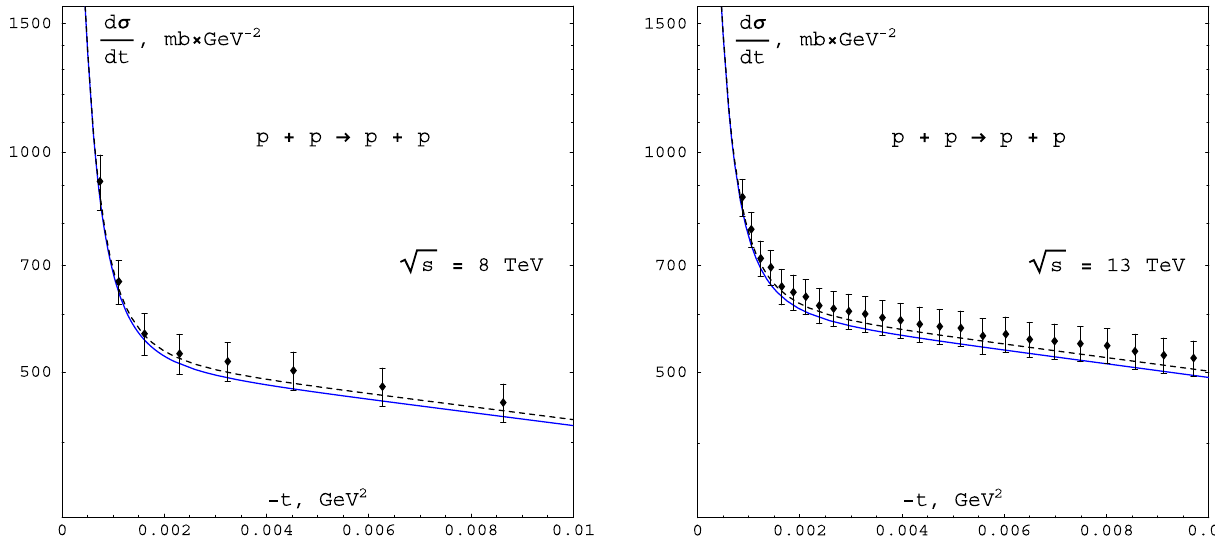
Fig. 7 The differential cross-sections of proton–proton EDS in the CNI region. The solid lines correspond to the two-Reggeon eikonal model. The dashed lines are related to the three-Reggeon approximation, wherein the HP exchange contribution is taken into